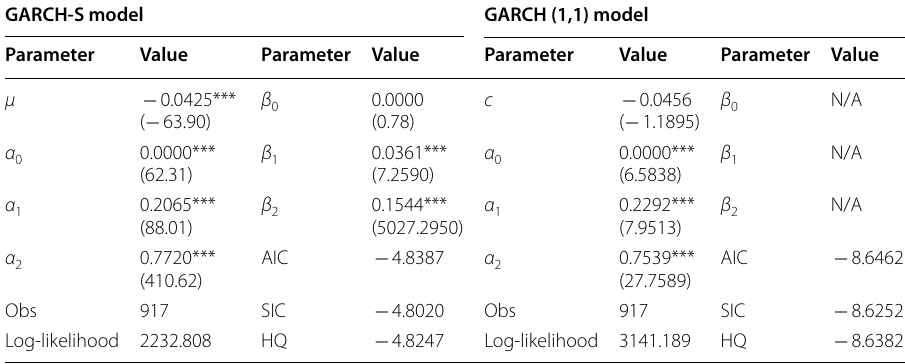
(1) ***, **, * represent statistical significance at 1%, 5%, and 10% levels, respectively. The z‑statistics are presented in the brackets. (2) Due to the high non‑linearity of the likelihood function, we use the starting values of parameters estimated from the simple GARCH (1,1)